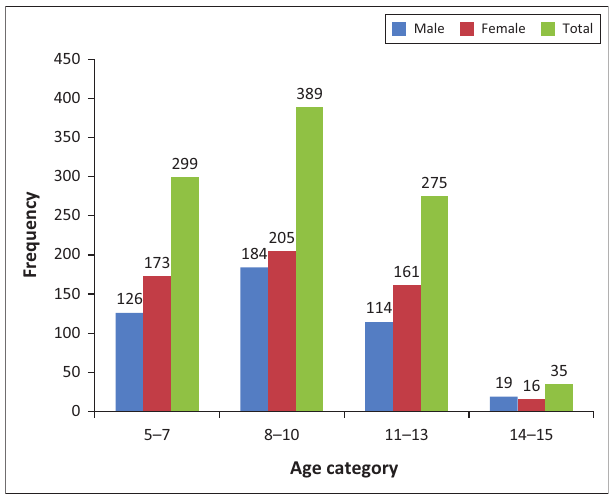
FIGURE 1: Demographic profiles of enumerated study population. TABLE 1: Distribution of uncorrected, presenting and best corrected visual acuity. VA category